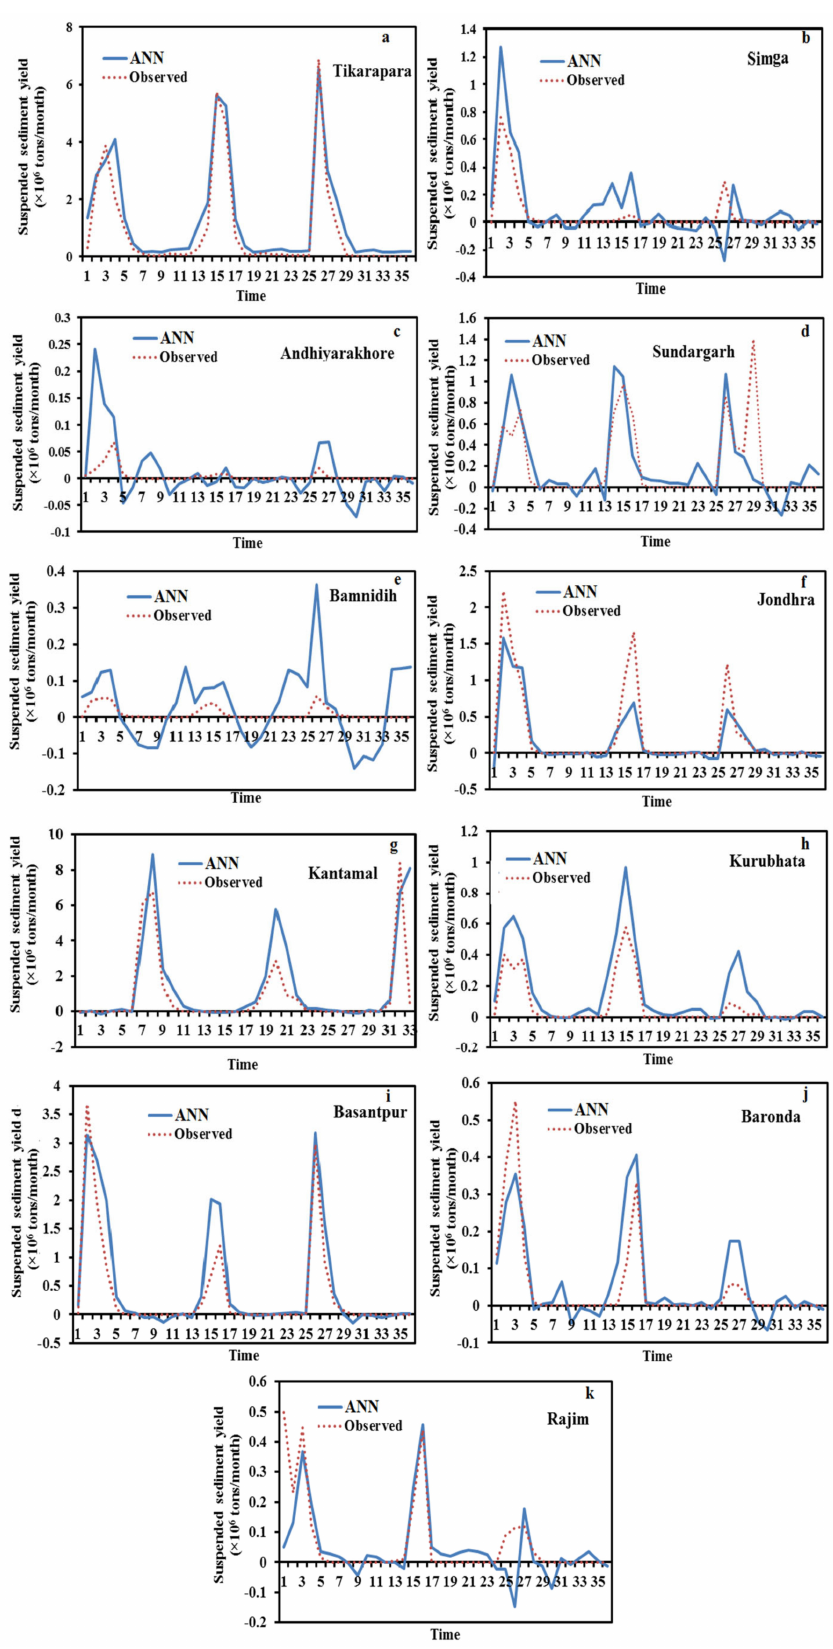
Figure 7. Hydrograph between predicted SSY and actual SSY of testing data of the ANN prediction